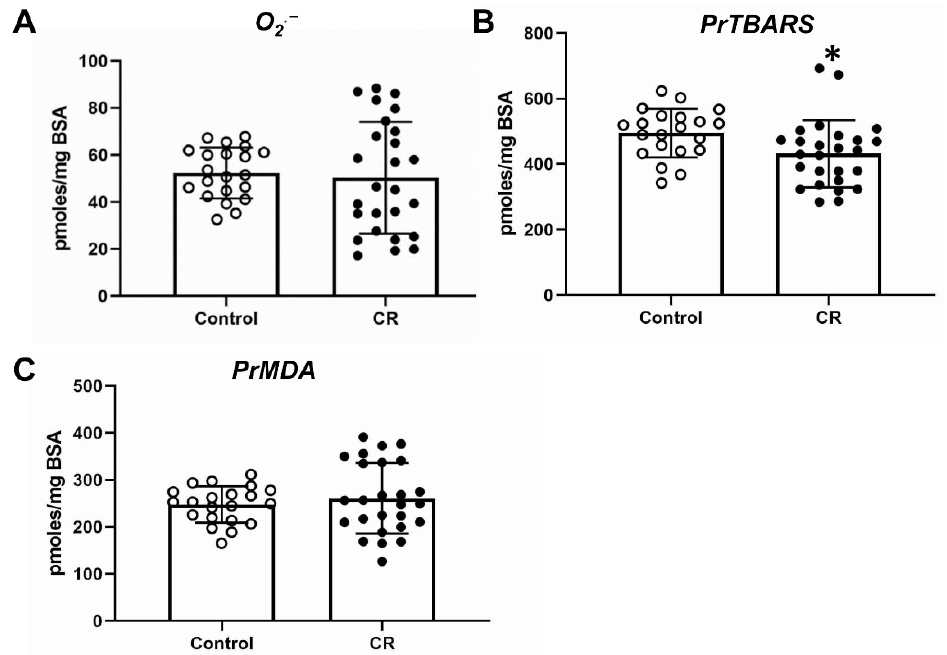
Figure 4. OS assessment in wild ‐ type embryonic livers: ( A ) superoxide radical (O 2• − ); ( B ) PrTBARS (protein bound thiobarbituric (TBA) reactive (lipoaldehydic) substances; ( C ) PrMDA (malondialde ‐ hyde (MDA) bound to total proteins). * p < 0.05. Control: fed ad libitum; CR: calorie restriction.